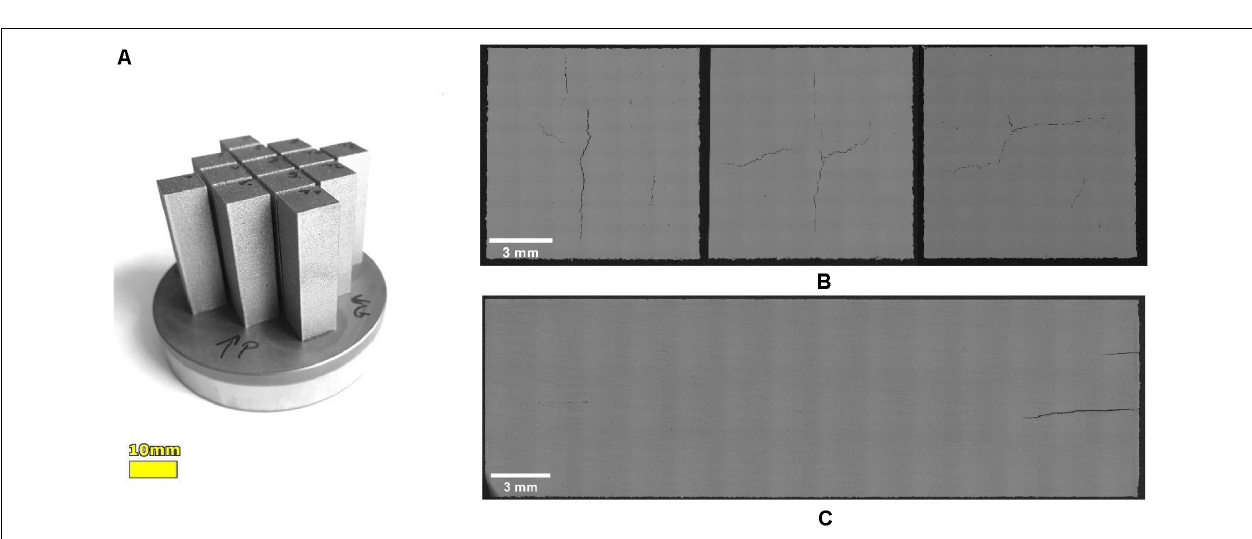
FIGURE 3 | (A) AlCrFe 2 Ni 2 LPBF coupons on the baseplate after the build and (B,C) optical microscopy micrographs in cross-section and longitudinal section of the coupons, respectively.